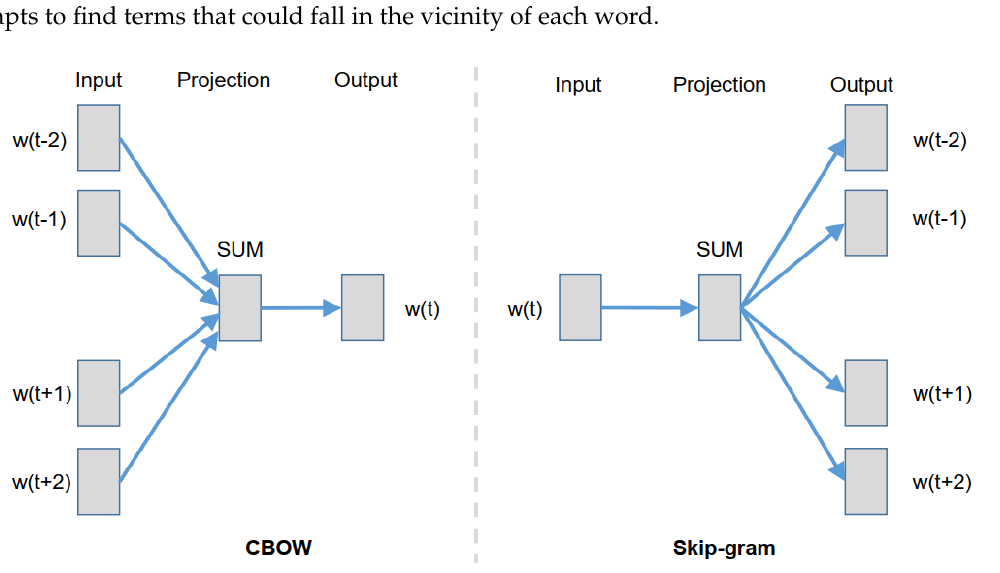
Figure 4. Continuous bag-of-words (CBOW) and Skip-gram model architecture. The Word2Vec technique implements both training models. The basic idea behind the two training models is that either a word is utilized to predict the context of it or the other way around—to use the context to predict a current word.